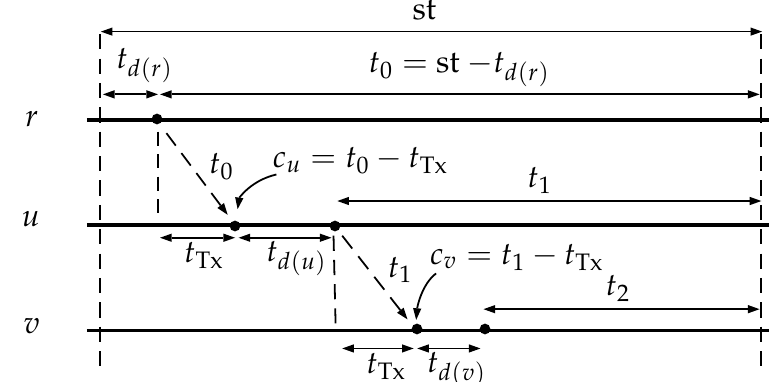
Figure 5. Illustration of the synchronization mechanism within a synchronization period (st), among nodes r , u and v connected in a chain topology. Nodes wait for a certain amount of time (i.e., t dr , t du and t dv , respectively) before transmitting the time remaining until the first time slot (i.e., t 0 , t 1 and t 2 , respectively). The internal clocks c u , c v along with the transmission time t tx are also depicted.